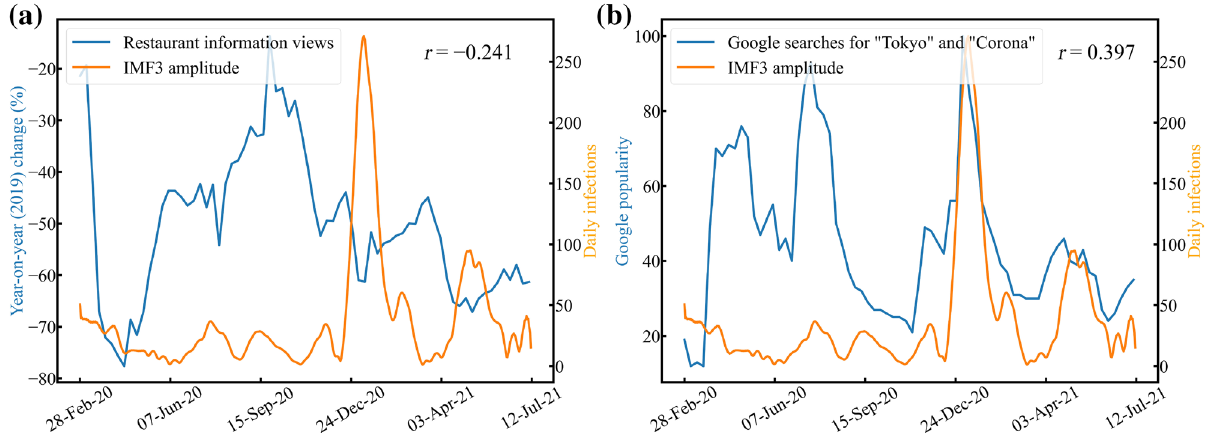
Figure 6. Correlations between decomposed IMF 3 and intervention effects (public health measures) and IMF 3 and information effects (social measures). ( a ) Year-on-year (2019) change in the number of restaurant information site views in Tokyo. ( b ) The popularity of Google searches for “Tokyo” and “Corona” in Japanese, obtained by Google